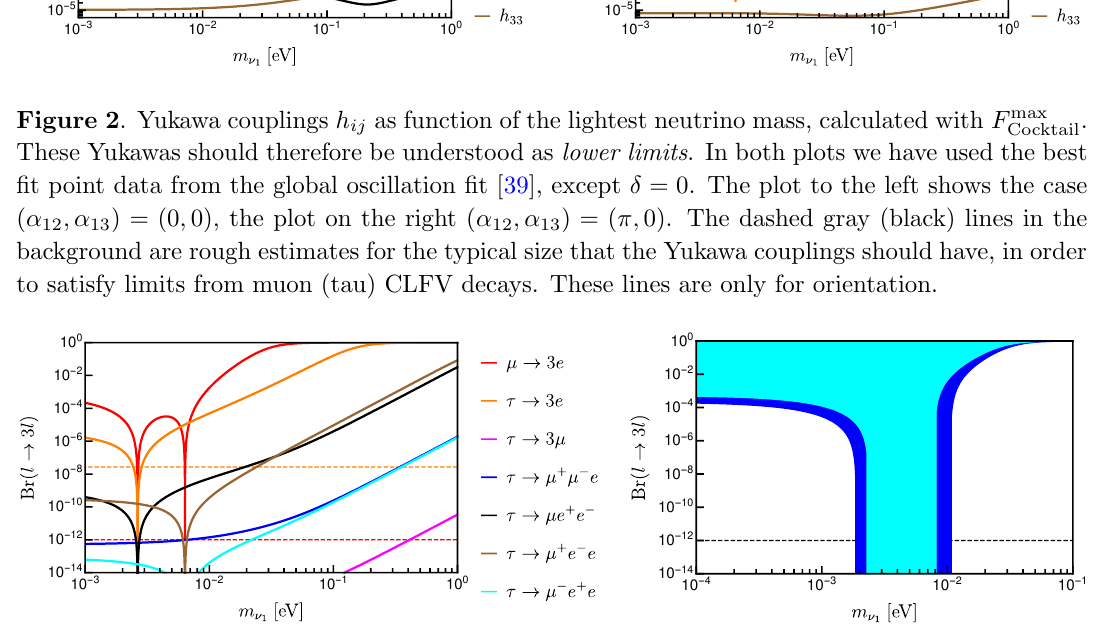
Figure 3 . Br( l i ! l j l k l m ) as function of the lightest neutrino mass. To the left, all di(cid:11)erent combinations of lepton generations are considered using the b.f.p. of oscillation data and (cid:11) 12 = (cid:25) and 2 (cid:14) (cid:11) 13 = 0. To the right, Br( (cid:22) 3 e ) scanned over the uncertainty in neutrino oscillation data (cid:0) ! is shown. The light and dark blue areas correspond to the 1 (cid:27) and 3 (cid:27) uncertainties, respectively. This plot scans over the Majorana